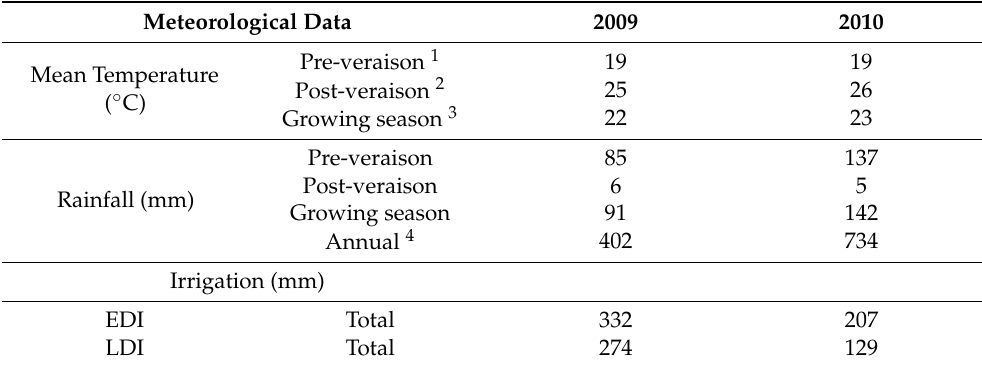
Table 5. Meteorological and irrigation data for the different irrigation treatments and years of